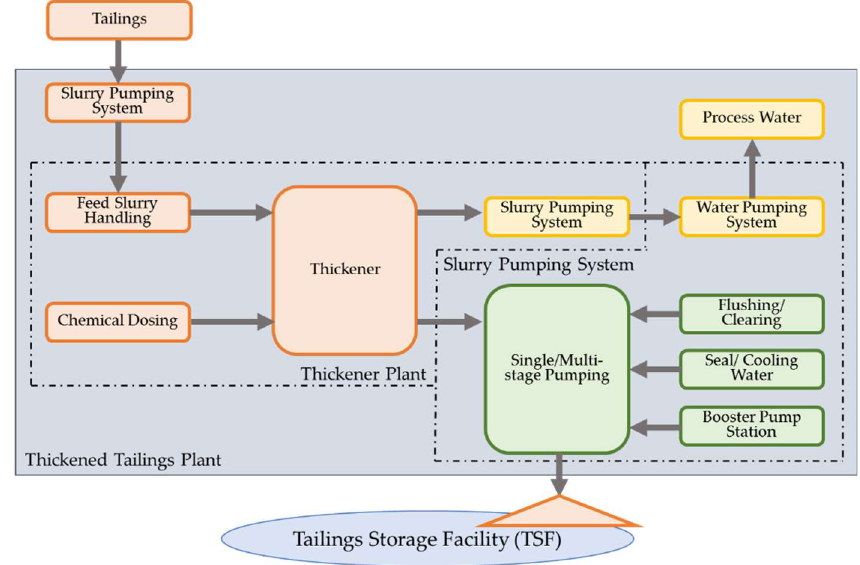
Figure 6. Simplified flowsheet of flotation tailings thickener (based on